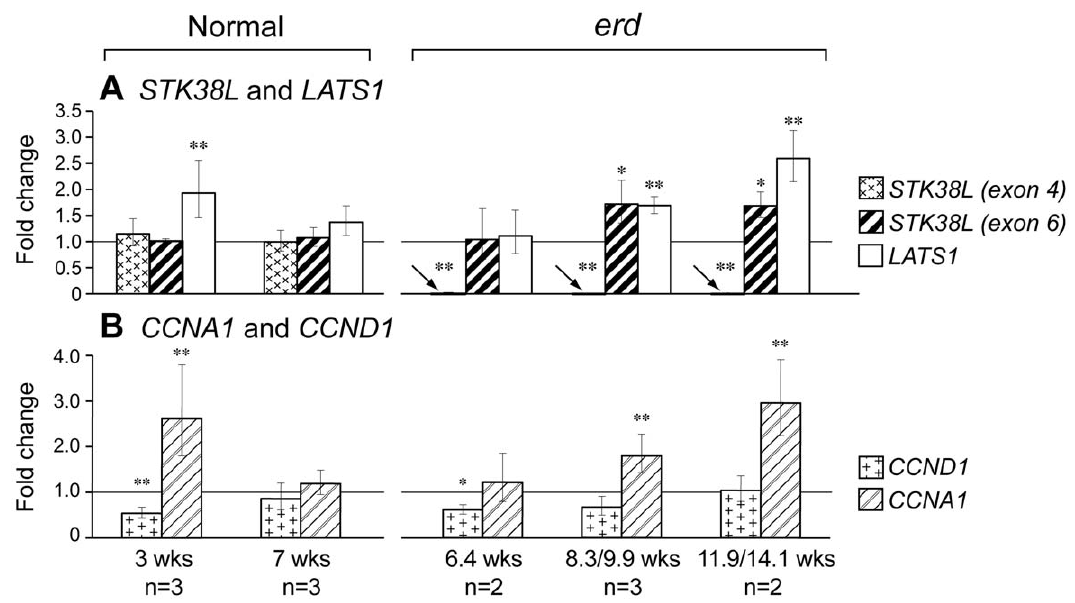
Figure 6. Retinal gene expression changes during normal development and disease. Expression was analyzed for genes that are ( A ) causally associated with the mutation or are part of the same gene family, or ( B ) involved with the cell cycle. Statistical significance between different groups in comparison to the 16 wks old normal control retinas (n=3), depicted by horizontal line at 1.0 Fold Change, was assessed with an unpaired t -test, and expressed as statistically significant (**=p # 0.05) or towards statistical significant (*=0.05 # p # 0.1). For STK38L , one probe was located within the exonic deletion [ STK38L (exon 4) ], and the second in exon 6, 3 9 to the splicing defect [ STK38L (exon 6) ]. Noted below each time point are the number of different samples used (n=) at each time